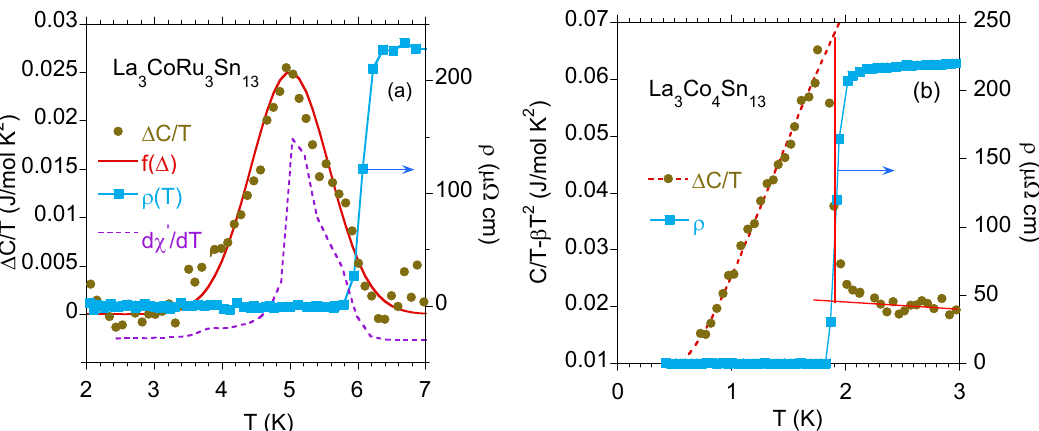
∆ C ( T ) Figure 3. ( a ) The temperature dependence of the specific heat of La 3 CoRu 3 Sn 13 was well T approximated by function f ( ∆ ) with the following parameters: ∆ 0 = 5.0 K and variance D = 0.3 K 2 , (cid:48) where ∆ C ( T ) = C ( T , B = 0 ) − C ( T , B = 5 T ) . The derivative d χ is also shown in arbitrary units. dT ( T ) For comparison, panel ( b ) exhibits C for La 3 Co 4 Sn 13 subtracted by the phonon contribution β T 2 , T ∆ C ( T ) ∆ C ( T ) − ∆ ( 0 ) = γ + A ] β = 3.5 mJ/mol K 2 . The data are well approximated by expression exp [ 0 T T T k B T (red dotted line) with the fitting parameters γ 0 = 8 mJ/mol K 2 and superconducting energy gap (cid:63) ∆ ( 0 ) = 2.6 K. La 3 Co 4 Sn 13 does not form the disordered T c phase. Both panels show the resistivity ρ ( T ) near the superconducting transition temperature. The critical temperature T (cid:63) c [in panel ( a )] or T c ( b ) is defined as T at 50% of the normal-state ρ